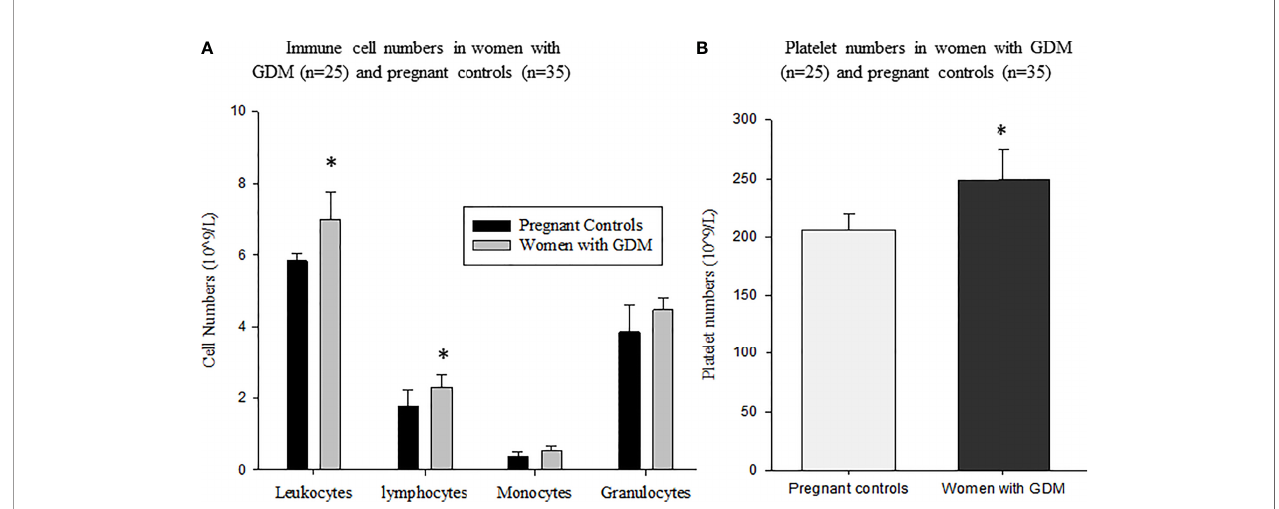
FIGURE 1 | Immune cell numbers in women with GDM (n = 25) and pregnant women without GDM as control group (n = 35): (A) total leukocytes, lymphocytes, monocytes and granulocytes; (B) Platelet numbers in women with GDM and pregnant controls. Values are means ± SD. *p values ( p < 0.05) indicate signi fi cant difference between women with GDM and pregnant controls. Statistical analyses were performed using the Student ’ s t-test or Mann-Whitney test.